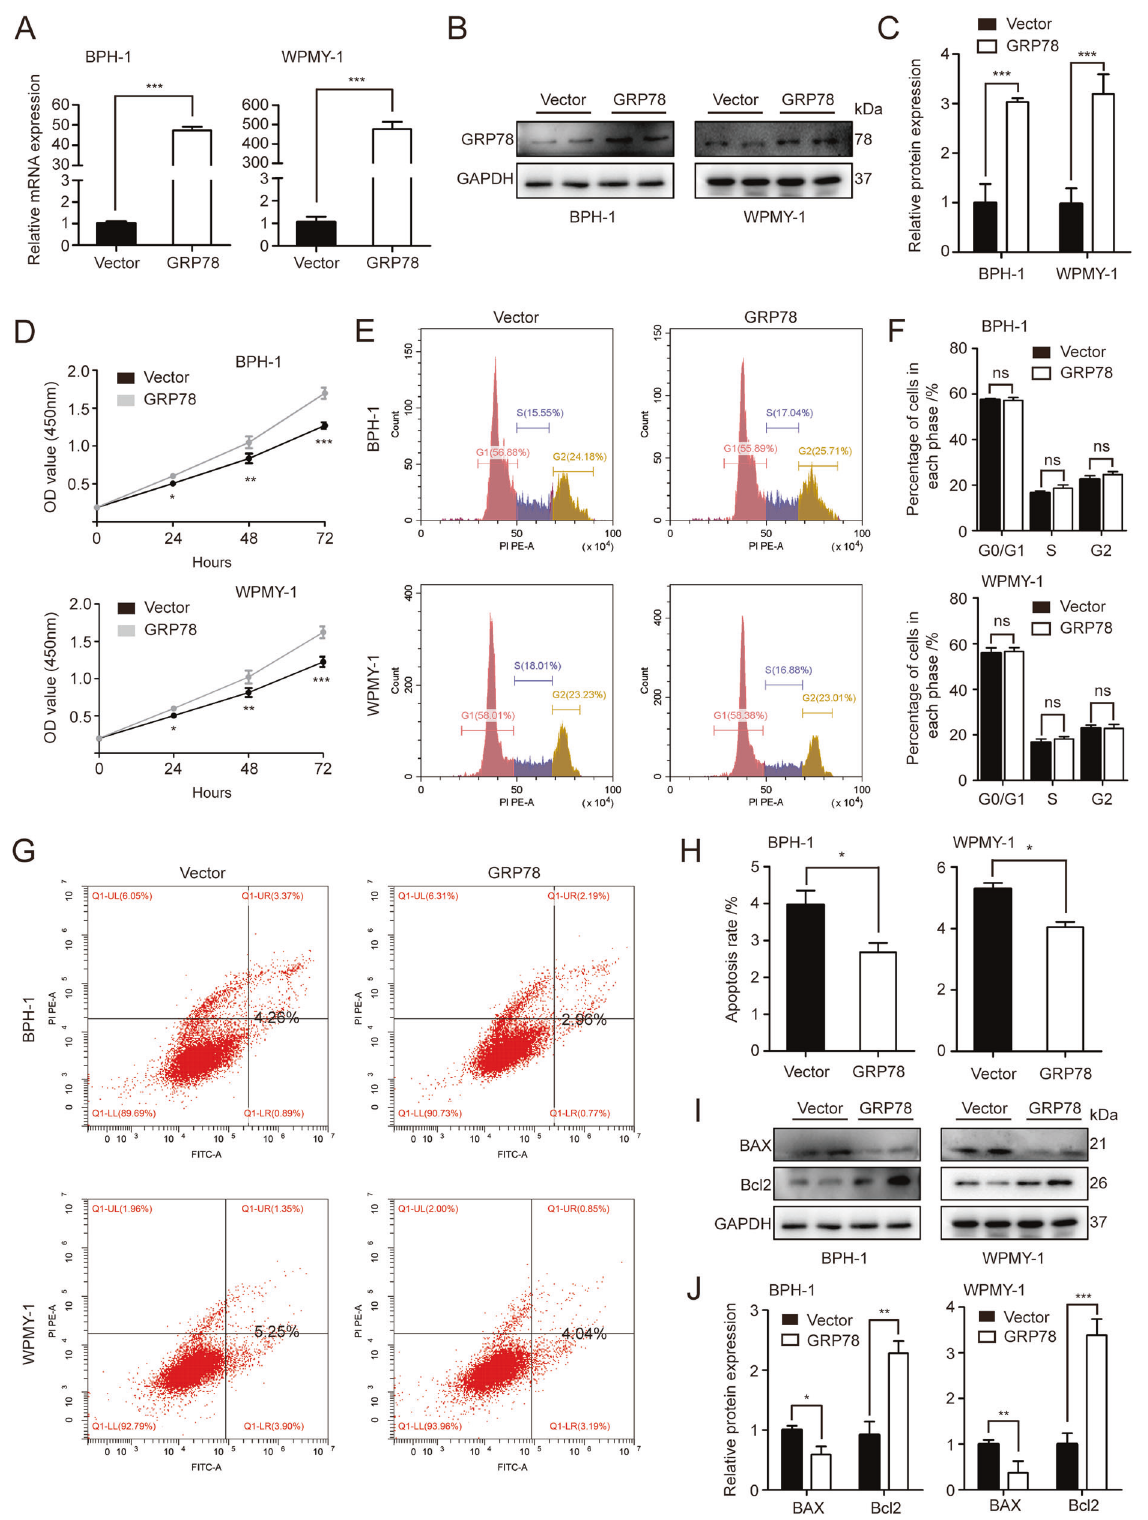
Fig. 3 Overexpression of GRP78 suppresses apoptosis and enhances viability of BPH-1 and WPMY-1 cells. A , B GRP78 mRNA and protein levels in prostate cells transfected with either GRP78 plasmid or vector. C Relative densitometric quanti fi cation of GRP78 protein expression. D The viability of prostate cells after transfection at different time points (0, 24, 48, 72 h). E Cell cycle detection for BPH-1 and WPMY-1 by fl ow cytometry analysis. The percentages (%) of cell populations at different cell cycle stages are listed within the panels. F Statistical analysis for the cell percentage in each cell cycle phase. G , H Detection of prostate cell apoptosis by fl ow cytometry analysis. Apoptotic cells are stained with Annexin V and PI. The apoptosis rates were statistically analyzed. I , J The protein expression and relative densitometric quanti fi cation of BAX and Bcl2 in BPH-1 and WPMY-1 cells after transfection. GAPDH is used as loading control. * p < 0.05; ** p < 0.01; *** p <